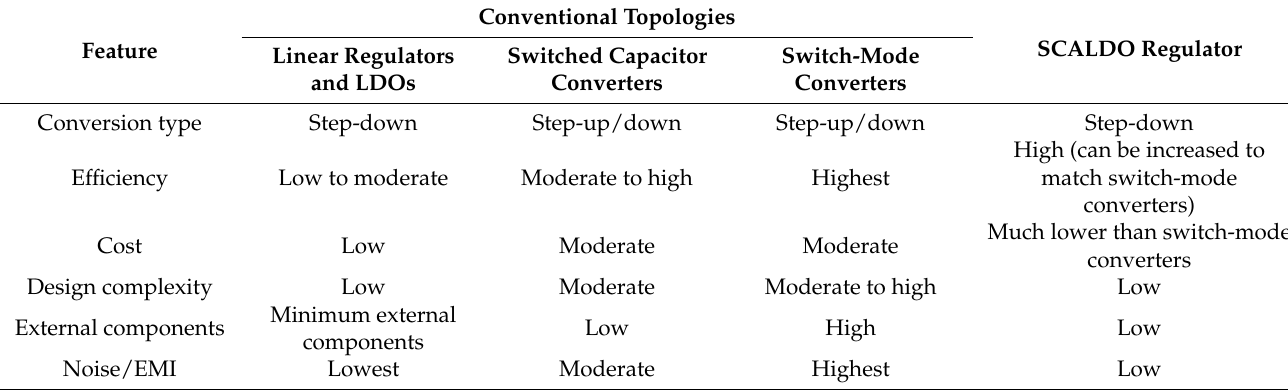
Table 3. Comparison of three basic DC-DC converter topologies and the SCALDO regulator